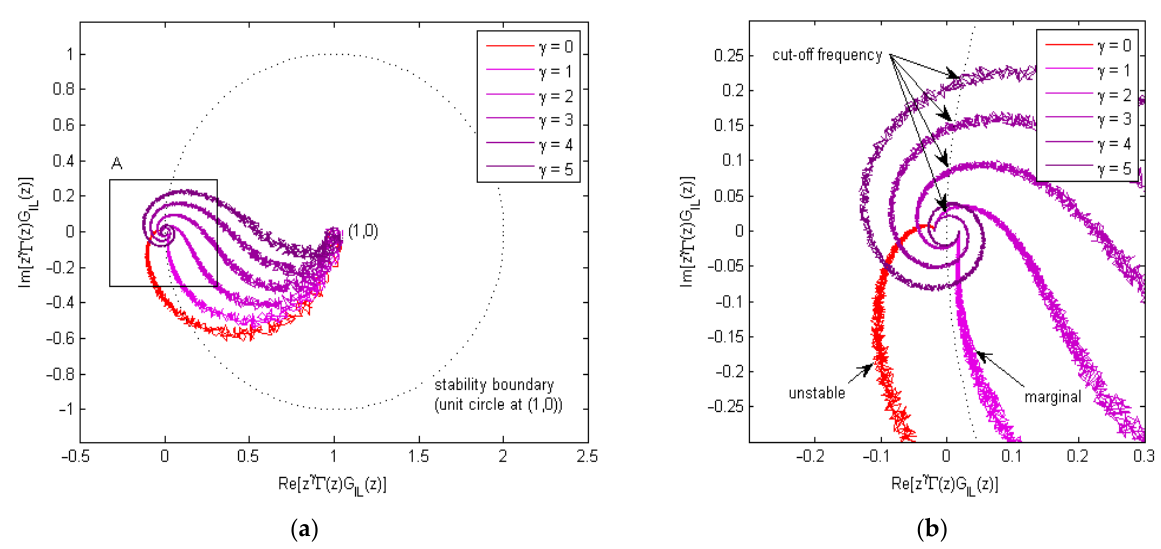
Figure 9. Stability plot using frequency domain analysis, with magnitude and phase noise added. And a basic P-type learning law with unity learning gain is used. ( a )Nyquist plot of z γ Γ ( z ) G IL ( z ) , with the unit circle stability boundary shown. ( b ) Zoom-in plot of region A in Figure 9a, where the outer learning loop is unstable for γ = 0, marginally stable for γ = 1 and requires frequency cut-off for γ = 2, 3, 4, 5.